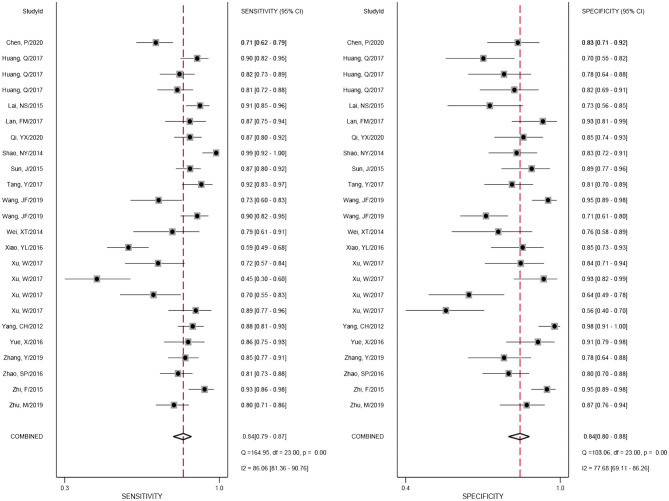
Forest plot of miRNAs for the diagnosis of gliomas.